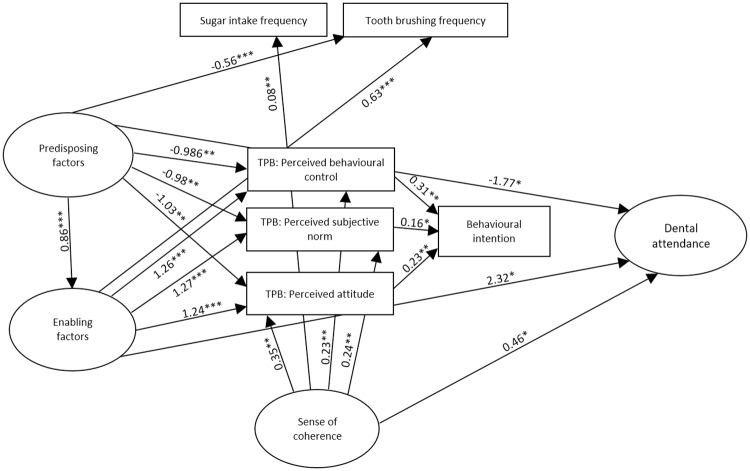
Bootstrapped standardized direct effect estimates for the amended TPB for dental attendance in preschool children illustrated with solid arrows.For ease of interpretation, only significant paths shown, and error and indicator variables omitted. * p < .05, ** p < .01, *** p ≤ .001.